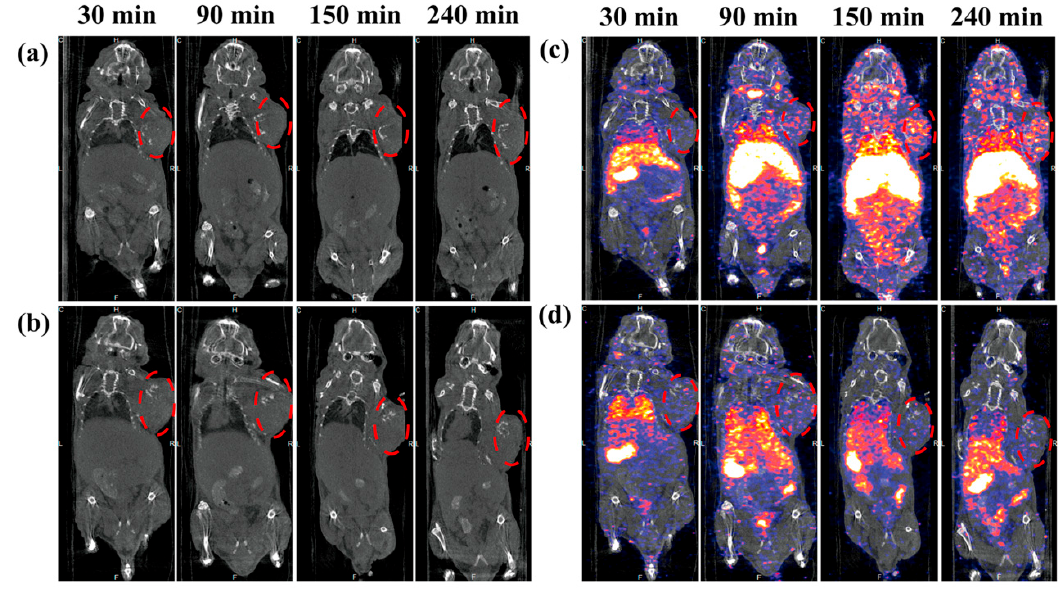
Figure 2. In vivo CT ( a , b ) and SPECT ( c , d ) images of tumors after intravenous injection of the {(Au°) 6 -G2-DTPA( 99m Tc)-PEG-FA} ( a , c ) or {(Au°) 6 -G2-DTPA( 99m Tc)- m PEG} ( b , d ) DENPs ([ 99m Tc] = 740 MBq·mL − 1 , Au = 0.08 M, in 100 μ L PBS) at different time points post-injection. The dashed red circles indicate the tumor sites (adapted from [73], ACS Applied Materials & Interfaces, 2016).